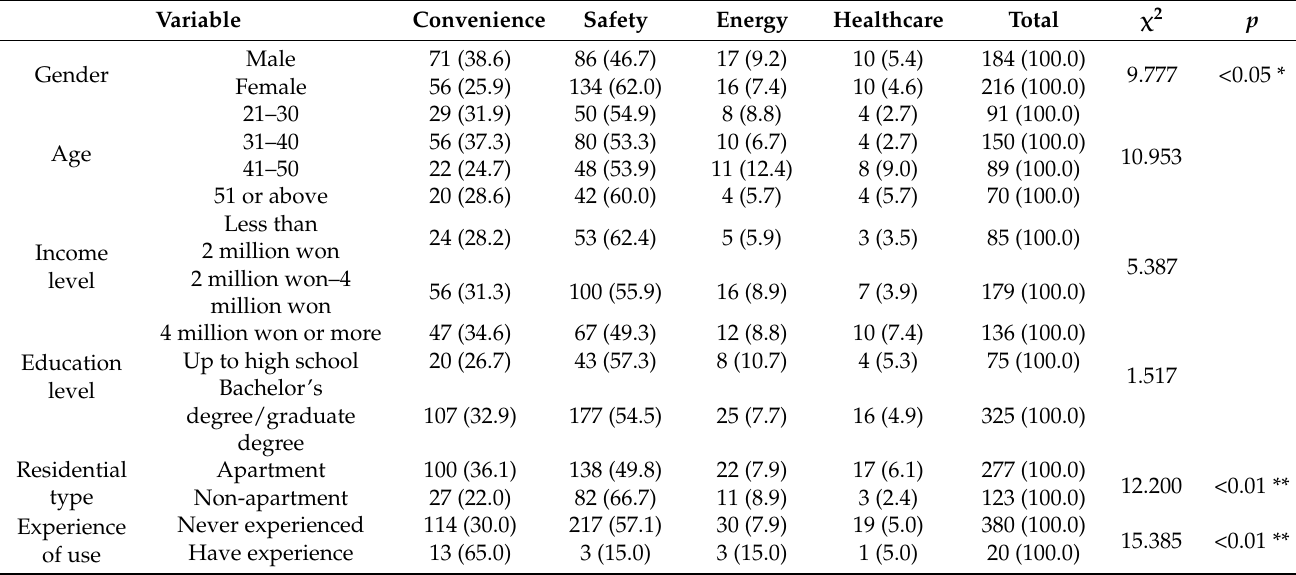
Table 3. Cross-tabulation analysis between service preferences and demographic characteristics (N = 400, * p < 0.05, ** p < 0.01).